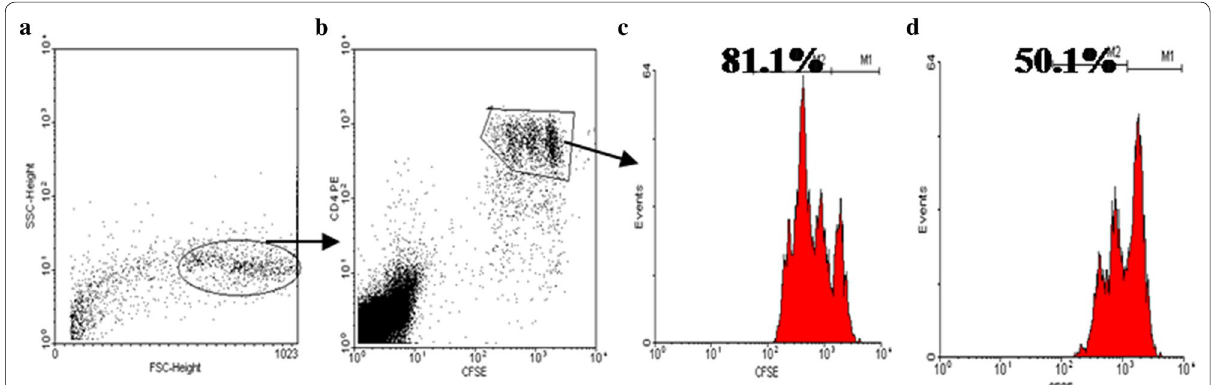
Fig. 5 The percentage of division of CD4 CD25- T effector cells with or without CD4 CD25 Tcells. CD4 CD25- T cells were labeled using + + + + Cell Trace ™ CFSE Cell Proliferation Kit before culture and cell division percentage was measured by flow cytometry after culture. a CBMC gate; b CD4 CFSE gate; c the percentage of newly divided CD4 CD25-T cells occupied 81.1% of the total effector cells after stimulated with PHA + + + without CD4 CD25 T reg cells; d the percentage of newly divided CD4 CD25- T cells occupied 50.1% of the total effector cells after stimulated + + + with PHA when cocultured with CD4 CD25 T reg cells. n 8. The gating strategy used is illustrated in Additional file 1: S3 + + =